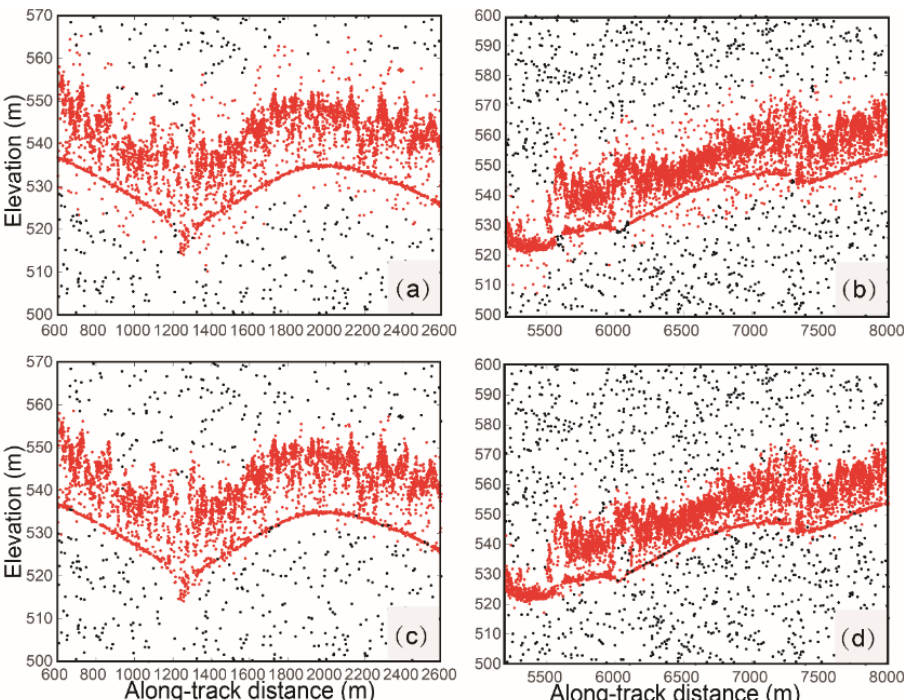
Figure 10. Partially enlarged views of the ICESat-2 data filtered by the LDS method ( a , b ) and the proposed method ( c , d ). Red dots represent signal photons; black dots represent noise photons. Table 1. Filter results of ICESat-2 data. Accuracy Indicators